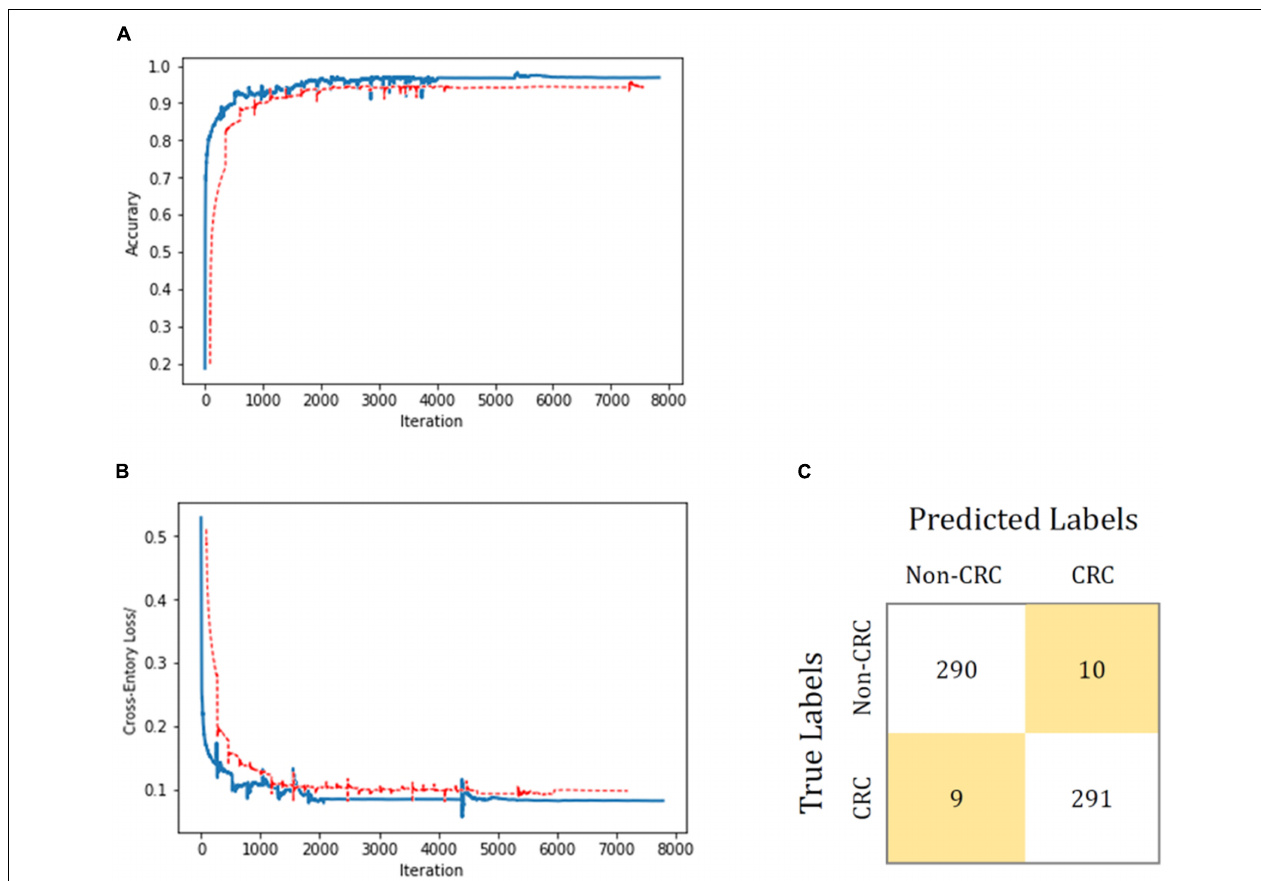
FIGURE 4 | Transfer-learning performance of CRC diagnosis using colorectal tissue microscope slide images. In (A,B) , the training dataset is shown in blue, and the test dataset is shown in red. Accuracy is plotted against the iteration step (A) , and cross-entropy loss is plotted against the iteration step (B) during the length of the training of the binary-class classifier over the course of 8,000 steps. The curve is smoothed; the test accuracy and loss show better performance. (C) Shows the confusion matrix of the best test image model classification. The model successfully classifies CRC separately from the